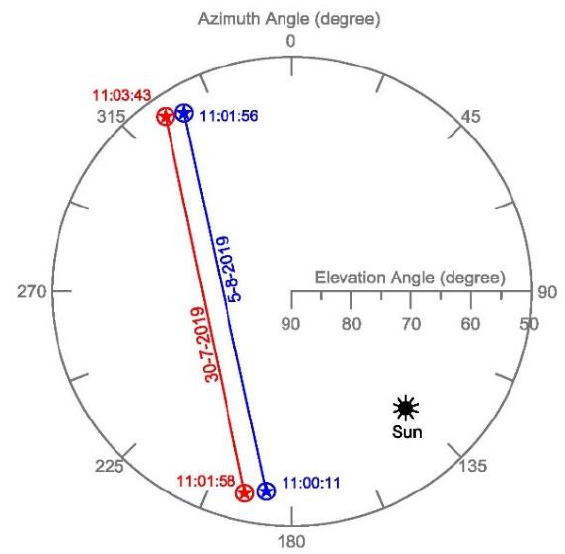
Figure 2. Sky plot with satellite azimuth and elevation angles at the time of acquisition for the two Deimos-2 stereo pairs.